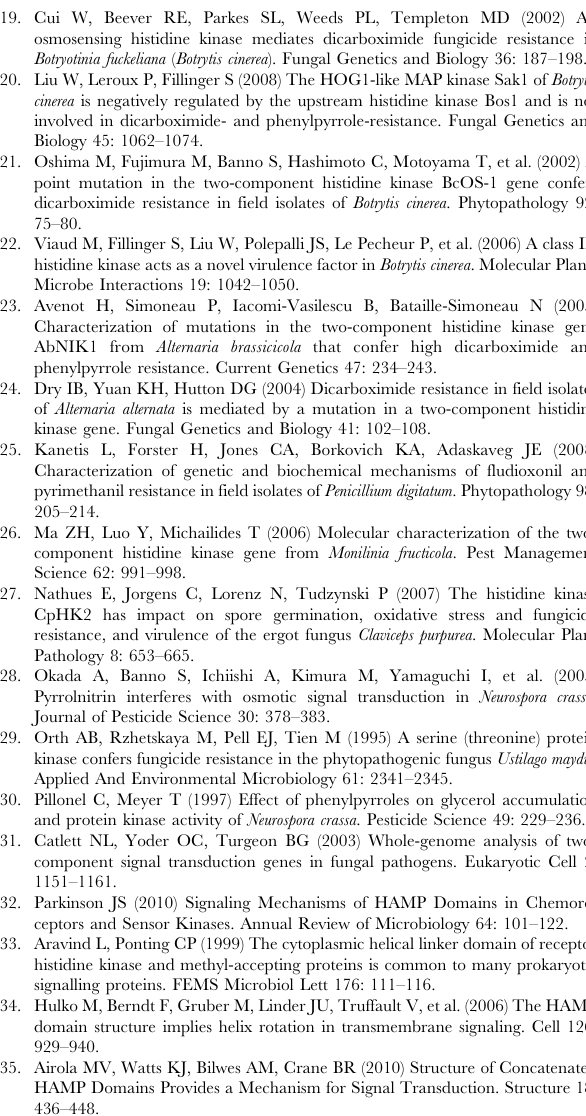
Table S1 In vitro response of pyrrolnitrin- and ipro- dione-induced mutants to pyrrolnitrin, iprodione, and phenylpyrroles. Table S2 Primers used in this study for amplification and sequencing of the bos1